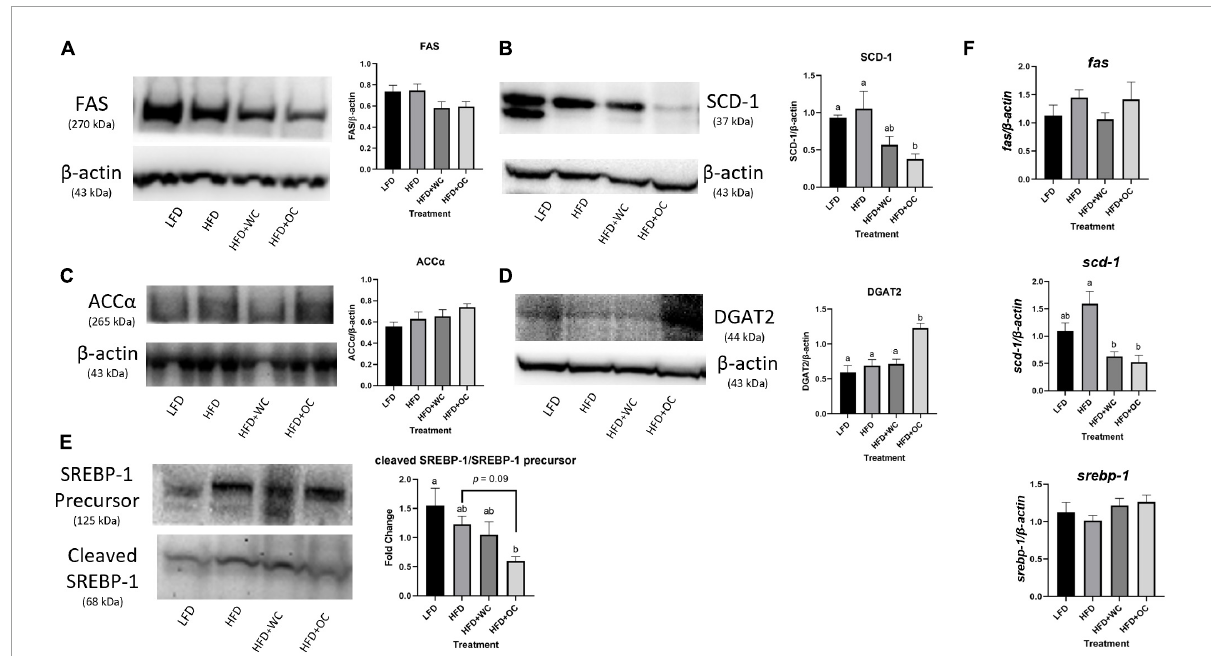
FIGURE4 Carotenoids minimally inhibit hepatic fatty acid synthesis. Western blot of hepatic (A) FAS, (B) SCD-1, (C) ACC α , (D) DGAT2, and (E) ratio of cleaved SREBP-1 to SREBP-1 precursor protein expression; blots in panels (A,C,E) performed with 3–8% tris-acetate gels; blots in panels (B,D) performed with 4–12% Bis-Tris gels; graphical changes between the dietary groups. (F) Changes in mRNA levels in hepatic fas , scd-1 , and srebp-1 generated from qPCR. For both western blot and qPCR, LFD: n = 11; HFD, HFD + WC, HFD + OC: n = 12. The fold change of mRNA and protein levels were analyzed by one-way ANOVA with post hoc Tukey HSD. Letter differences indicate statistical significance ( p <